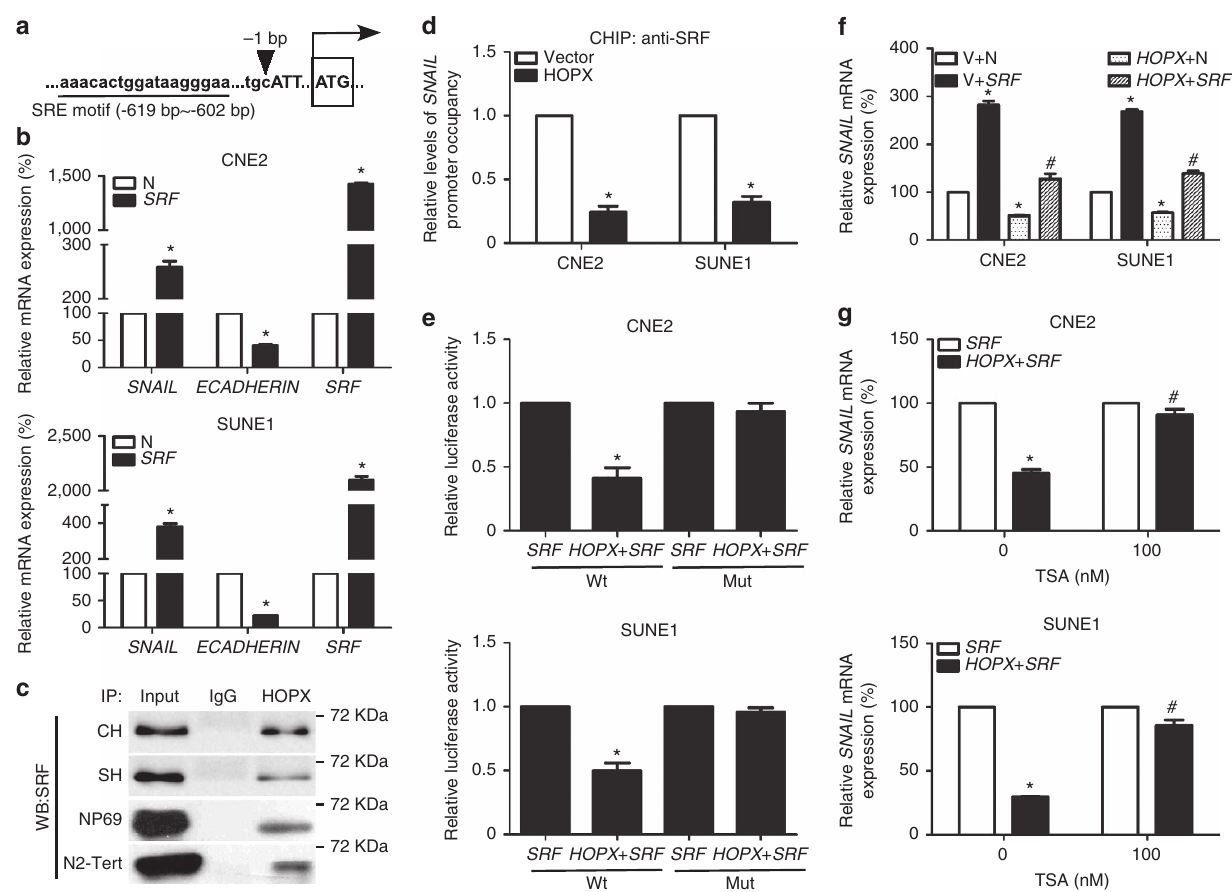
Figure 6 | HOPX epigenetically inhibits SRF-mediated SNAIL transcription in NPC. ( a ) Sketch map of the SRE motif within the SNAIL promoter predicted by JASPAR software. Upper case letters: exon. ( b ) Relative SNAIL , ECADHERIN and SRF mRNA expression levels were determined via real-time RT–PCR in CNE2 and SUNE1 cells stably overexpressed the control N or SRF . Mean ± s.d.; * P o 0.01 compared with N; Student’s t -tests. ( c ) Co-IP assays were used to measure the interaction between HOPX and SRF in CH, SH, NP69 and N2-Tert cells. CH and SH cells indicated CNE2 and SUNE1 cells with stable HOPX overexpression; WB, western blotting assay. ( d ) ChIP real-time PCR assays were applied to measure the enrichment of SRF in the SNAIL promoter in CNE2 and SUNE1 cells stably overexpressed the vector or HOPX . Mean ± s.d.; * P o 0.01 compared with vector; Student’s t -tests. ( e ) Wild-type and mutant SNAIL -luciferase reporters were constructed and co-transfected with SRF or/and HOPX in CNE2 and SUNE1 cells. Luciferase reporter assay was used to detect the luciferase activity of SNAIL promoter. Mean ± s.d.; * P o 0.01 compared with SRF ; Student’s t -tests. ( f ) CNE2 and SUNE1 cells were co-transfected with HOPX or/and SRF . V and N were used as empty vectors of HOPX and SRF , respectively. Relative SNAIL mRNA expression was measured via real-time RT–PCR. Mean ± s.d.; * P o 0.01 compared with V þ N; # P o 0.01 compared with HOPX þ N; Student’s t -tests. ( g ) Real-time RT–PCR was applied to assess the relative SNAIL mRNA expression following transfection with SRF or/and HOPX . TSA (0 and 100nM) was treated with CNE2 and SUNE1 cells. Mean ± s.d.; * P o 0.01 compared with SRF ; # P o 0.01 compared with TSA (0nM); Student’s t -tests. These data are representative of three independent